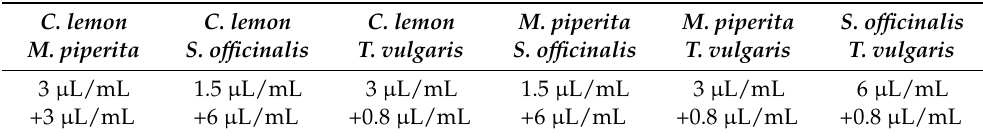
Table 2. MICs of the most advantageous EO/EO associations (chosen based on the FIC-Index) added to the coatings.